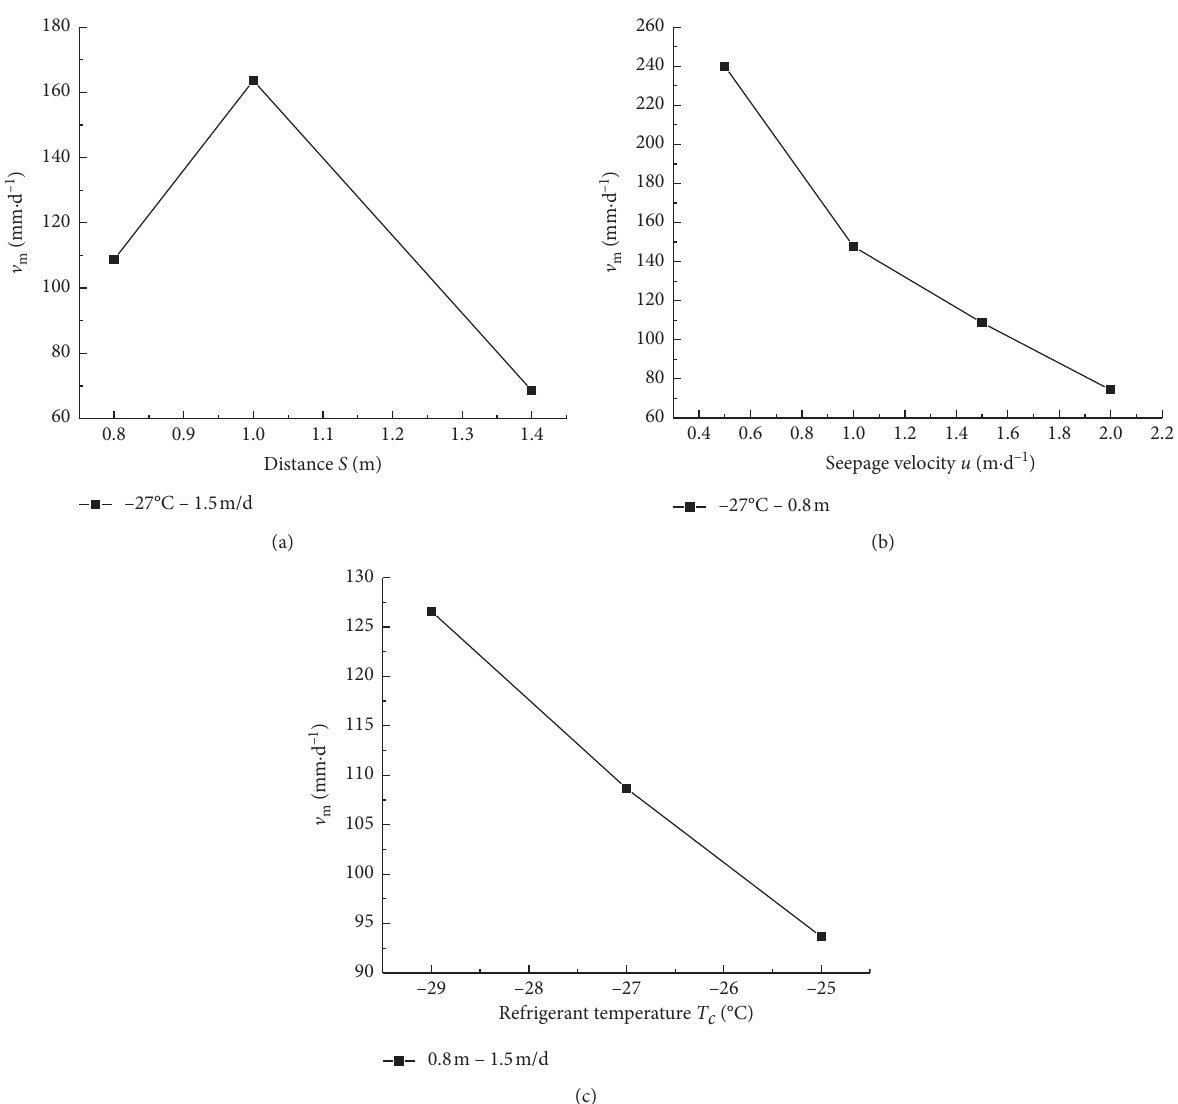
Figure 9: Influences of various factors on v temperature T c vs. v m .